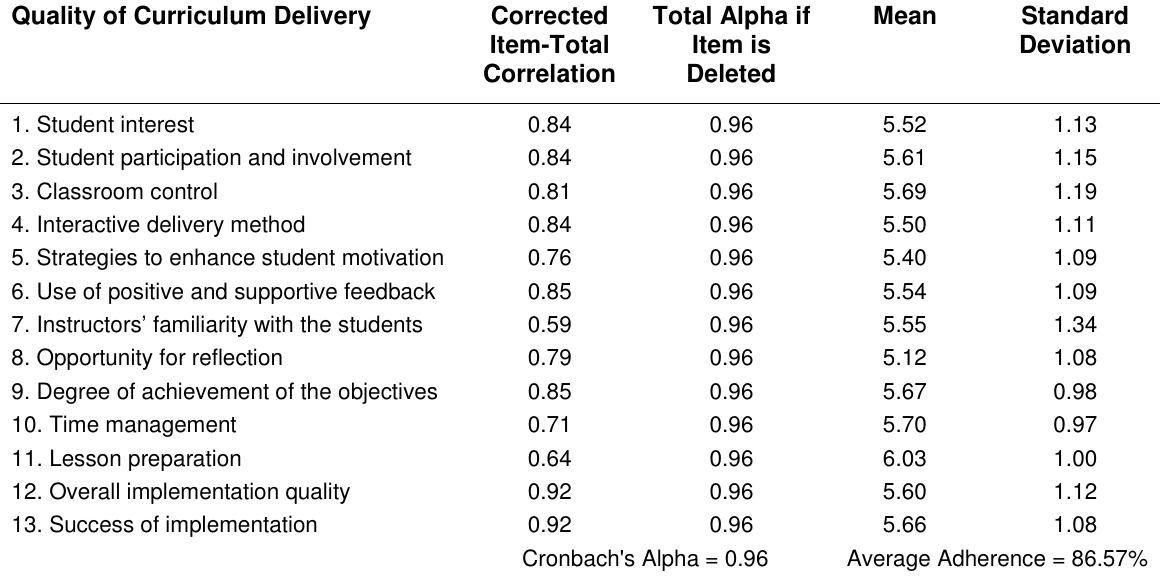
Cronbach Alpha Coefficients, Means and Standard Deviations of the Curriculum Delivery Assessment Scale, and Average Adherence